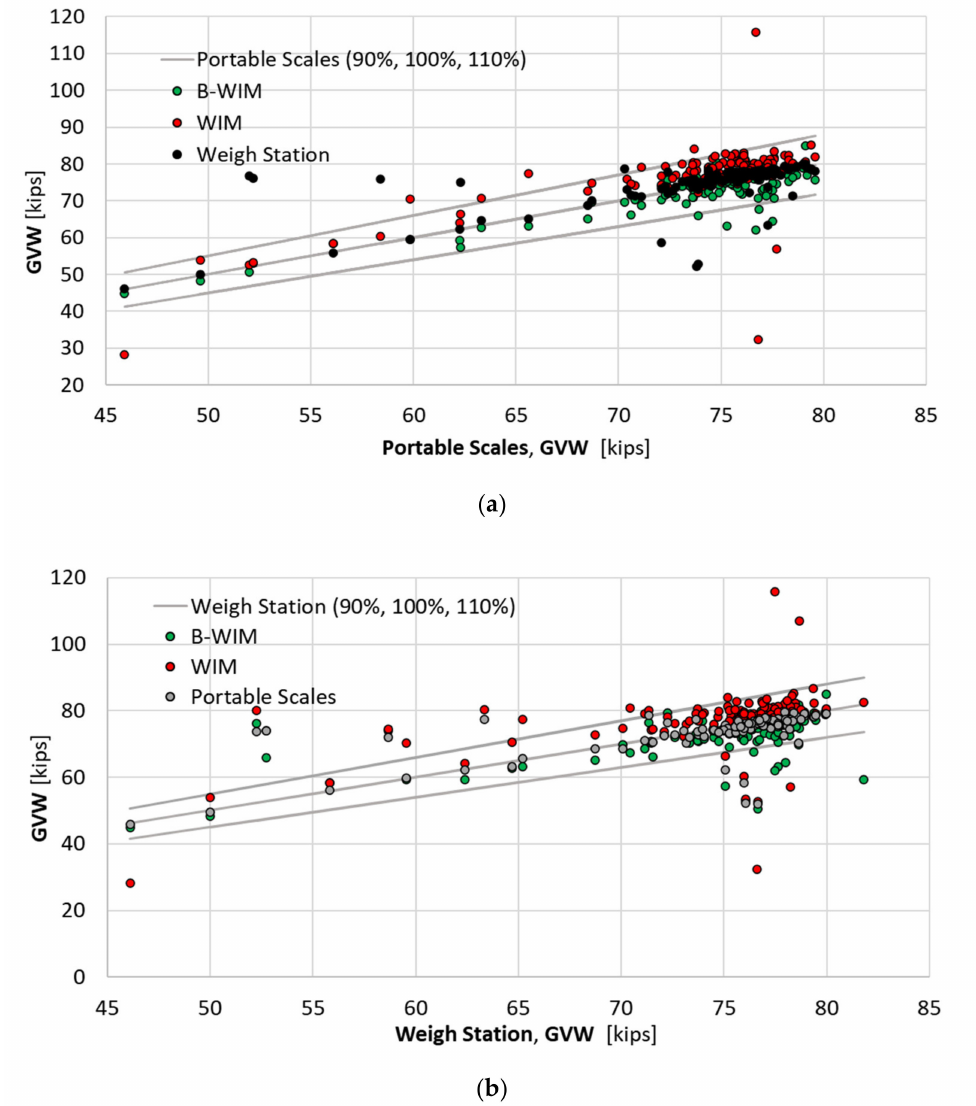
Figure 8. GVW measurement tolerances ( a ) compared to portable scales measurement, ( b ) compared to weigh station